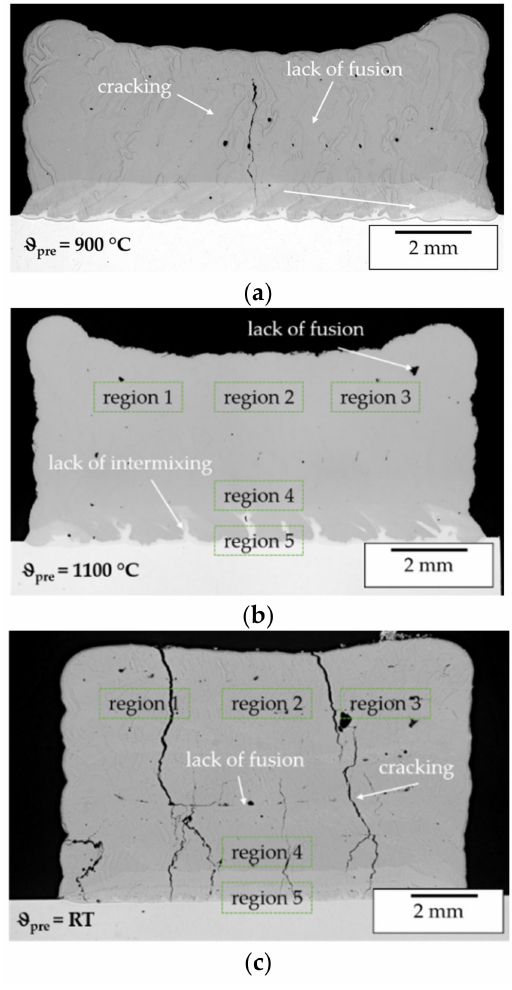
Figure 18. LOM images of cuboid specimens manufactured using pre-alloyed powder (( a ) preheating temperature 900 ◦ C; ( b ) preheating temperature 1100 ◦ C) and in situ alloying (( c ) no preheating), marked regions indicate areas analyzed by